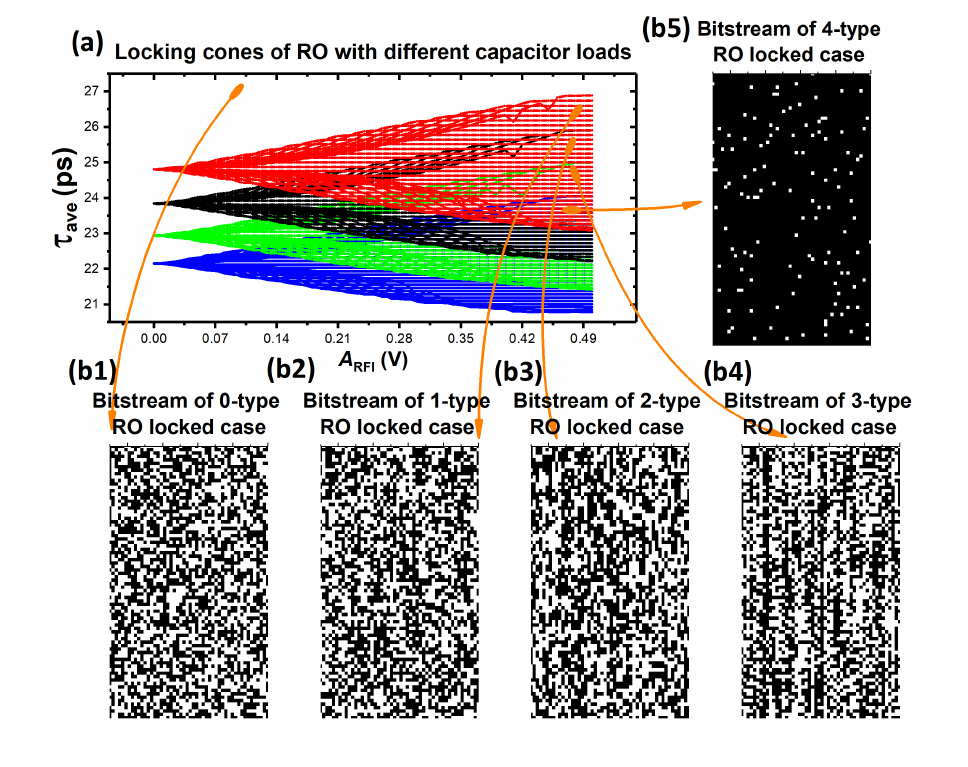
Figure 12. Experiment results of Case 2: changing capacitor load case. ( a ) Locking cones of ROs with different capacitor loads; ( b1 – b5 ) bitstream maps with different types of ROs